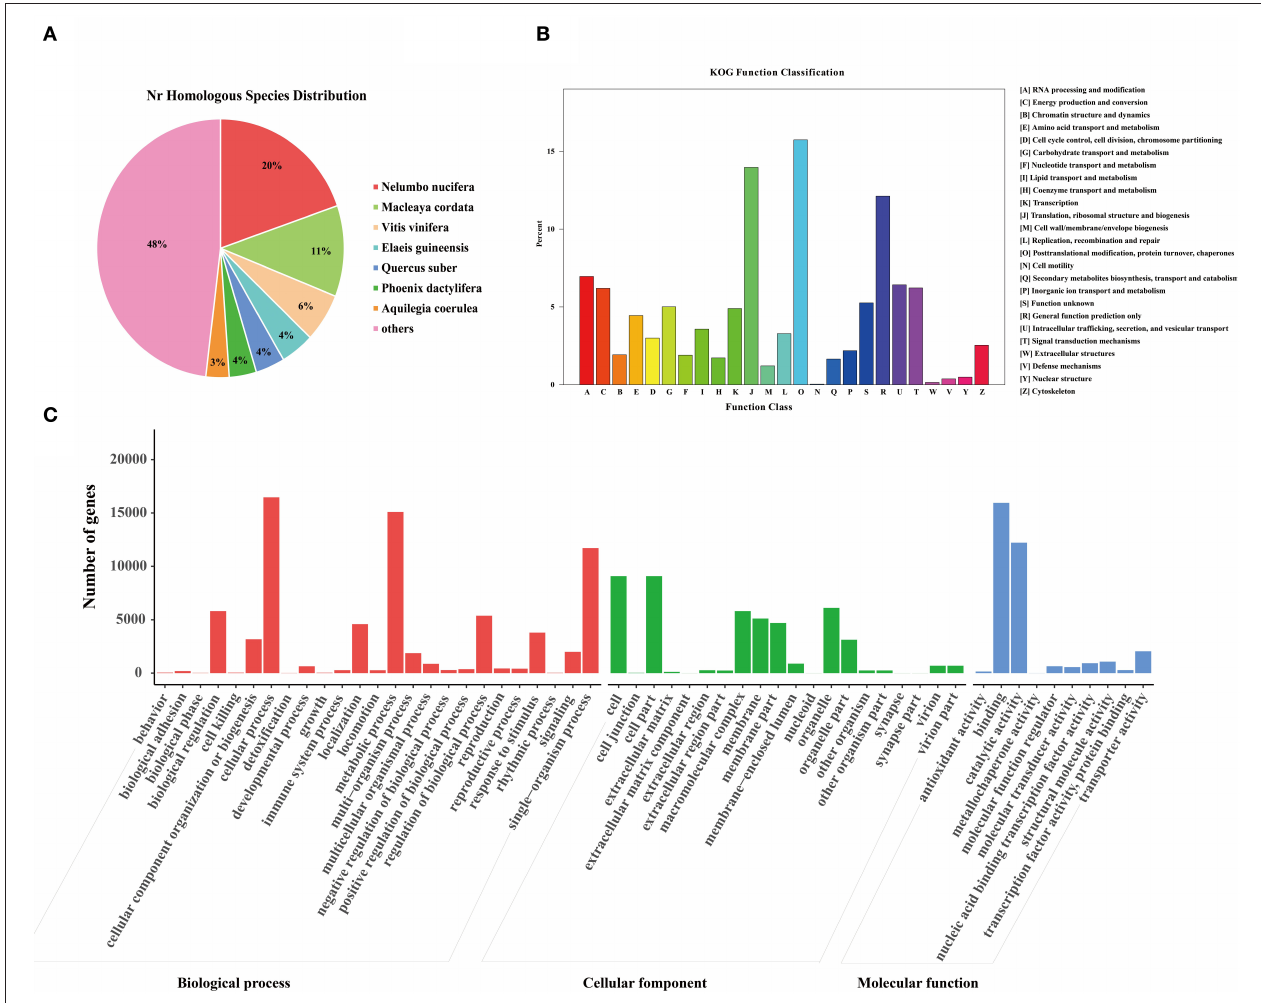
FIGURE 3 | Functional annotations of the unigenes of the M. microcarpa transcriptome. (A) Species distribution of the NR results of M. microcarpa transcriptome. (B) KOG function annotation of unigenes. (C) GO function annotation of